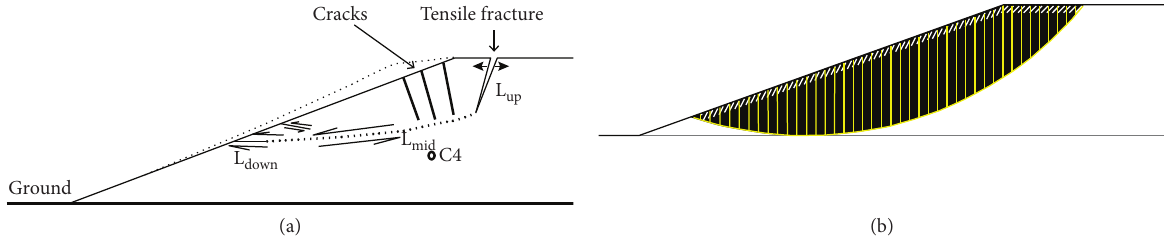
Figure 10: Potential sliding surface of slope in different methods. (a) Potential sliding surface (shaking table test). (b) Sliding surface of automatic search